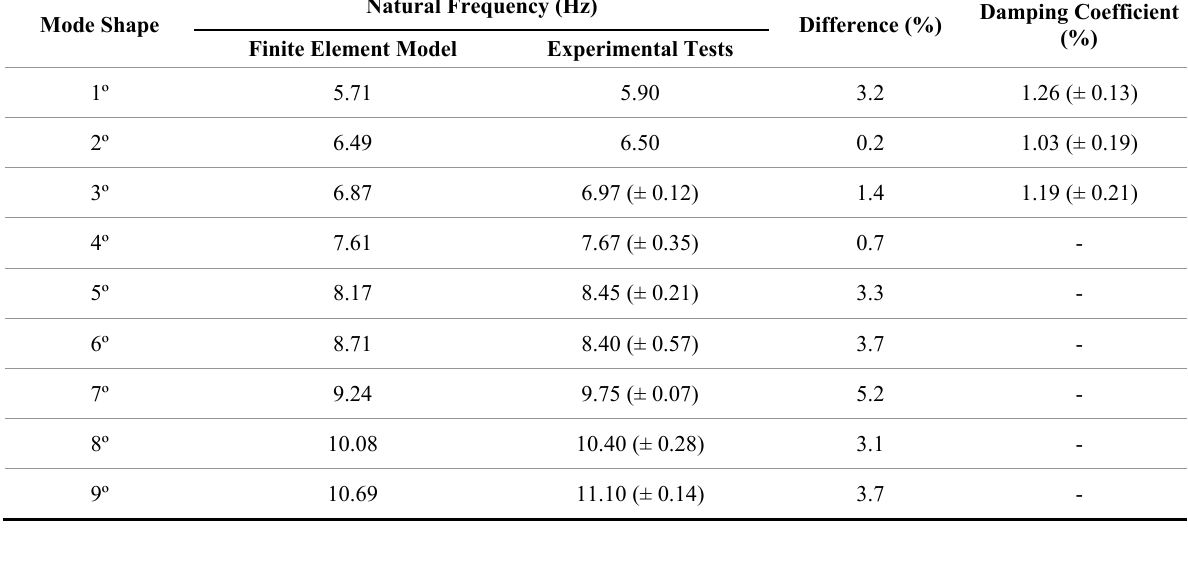
Table 2. Evaluated floor’s natural frequencies comparison.